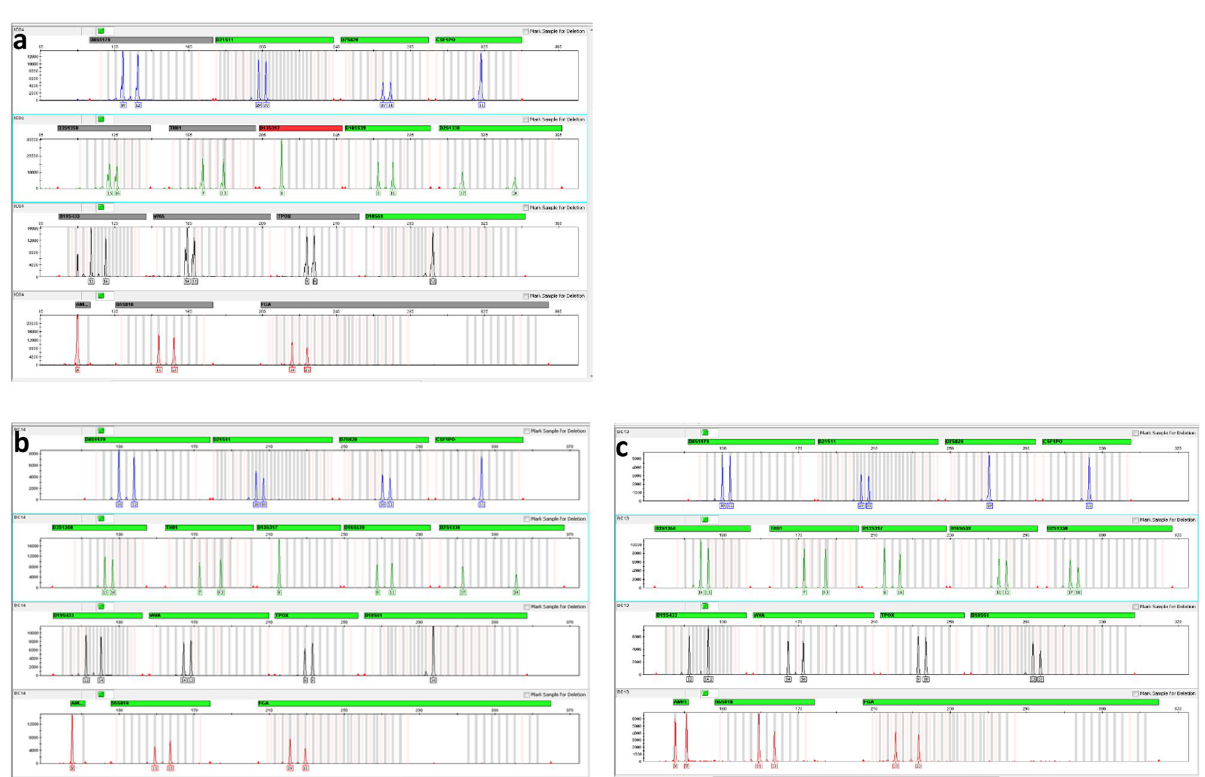
Figure 1. Representative results of genotypic profiles at 16 loci. The vertical axis shows the amplitude of florescence intensity of the polymerase chain reaction product and the horizontal axis shows the DNA fragment size in base pairs. The genotypic analysis of the transplanted cornea ( a ) of patient 3 at 30 months after allo-SLET is interpreted as a donor genotype when the genetic match was found with his donor reference ( b ) not his own recipient reference ( c